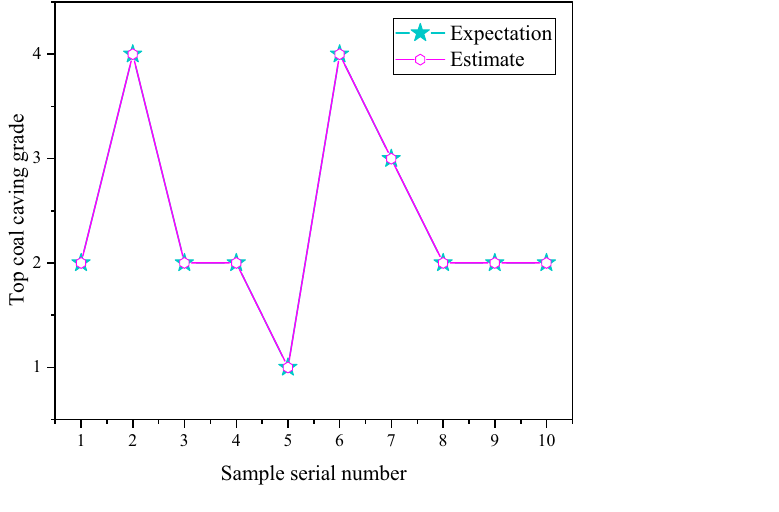
Figure 6. Model test